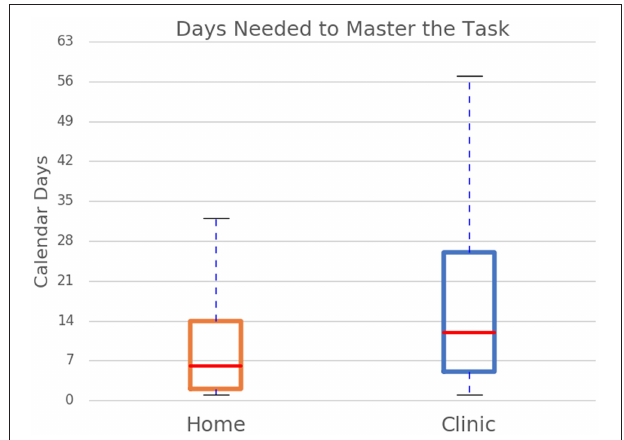
FIGURE 1 | Summary of median calendar days needed to master the task by user group.